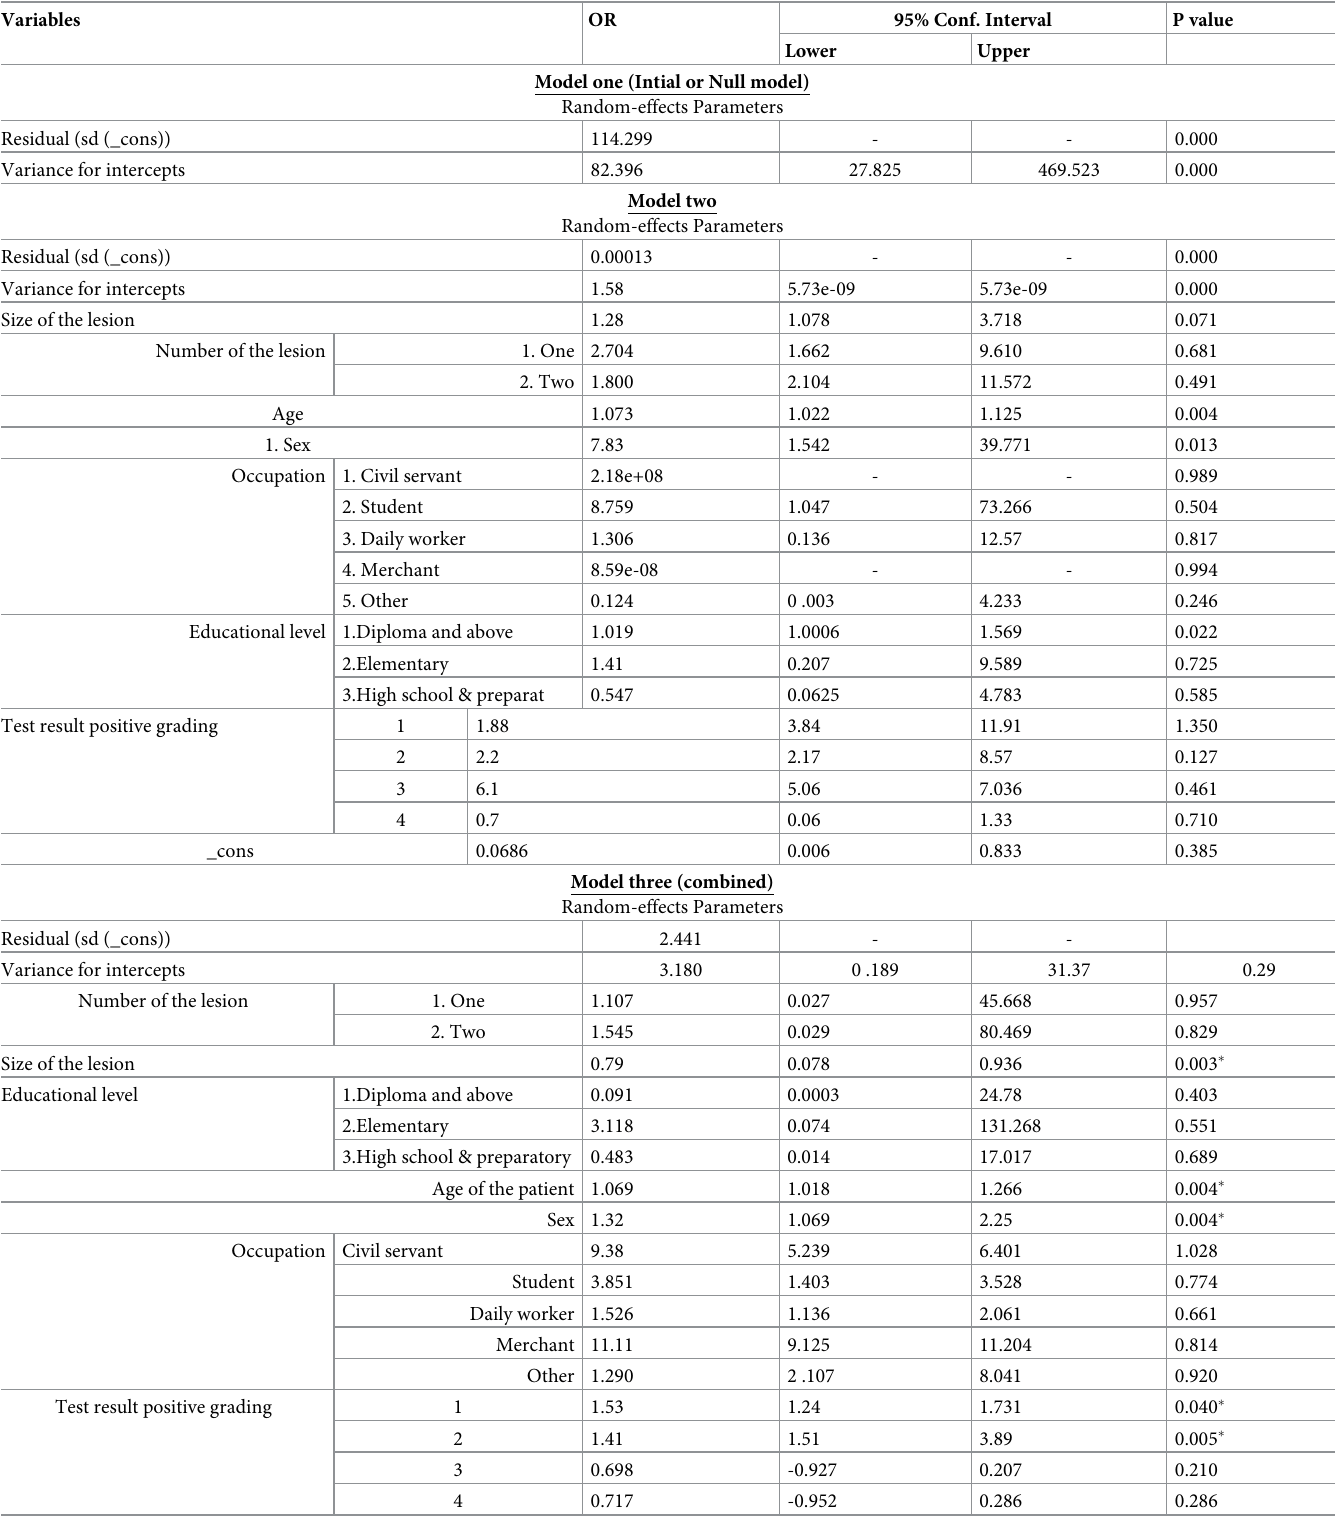
Table 4. Multi-level logistic regression or fixed effects on the effectiveness of IL SSG for the treatment of LCL, Boru Meda general hospital,